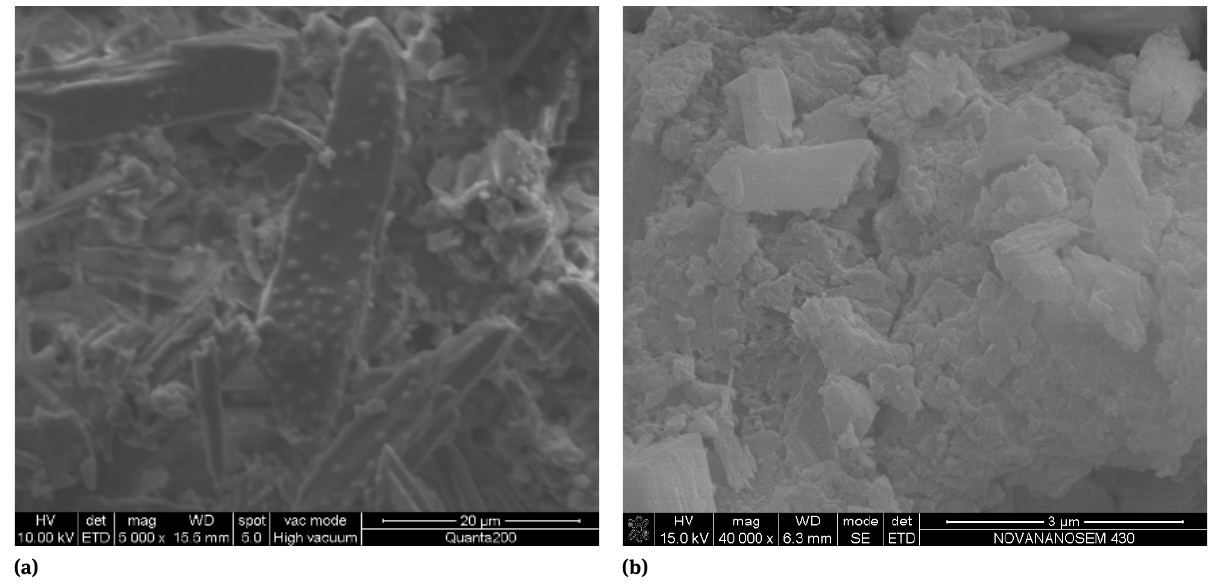
Figure 15: Nanostructures of UV curable Hybrid Coatings